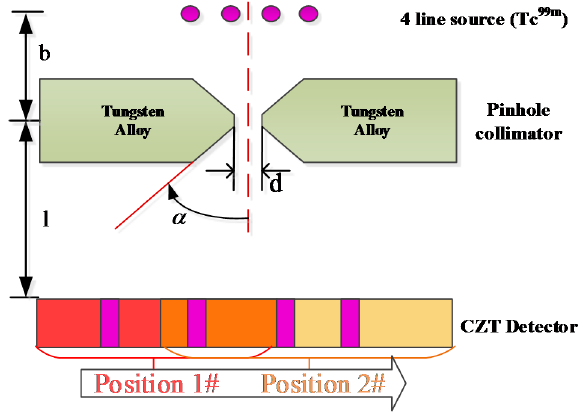
Figure 5. The geometry of keel-edge pinhole aperture and four linear sources phantom, where b is the perpendicular distance between source and the focal point (pinhole center), l is focal length, d is the physical diameter of pinhole, α is half of the pinhole opening angle. The center distance between each source is 4 mm. This geometric configuration approximately results